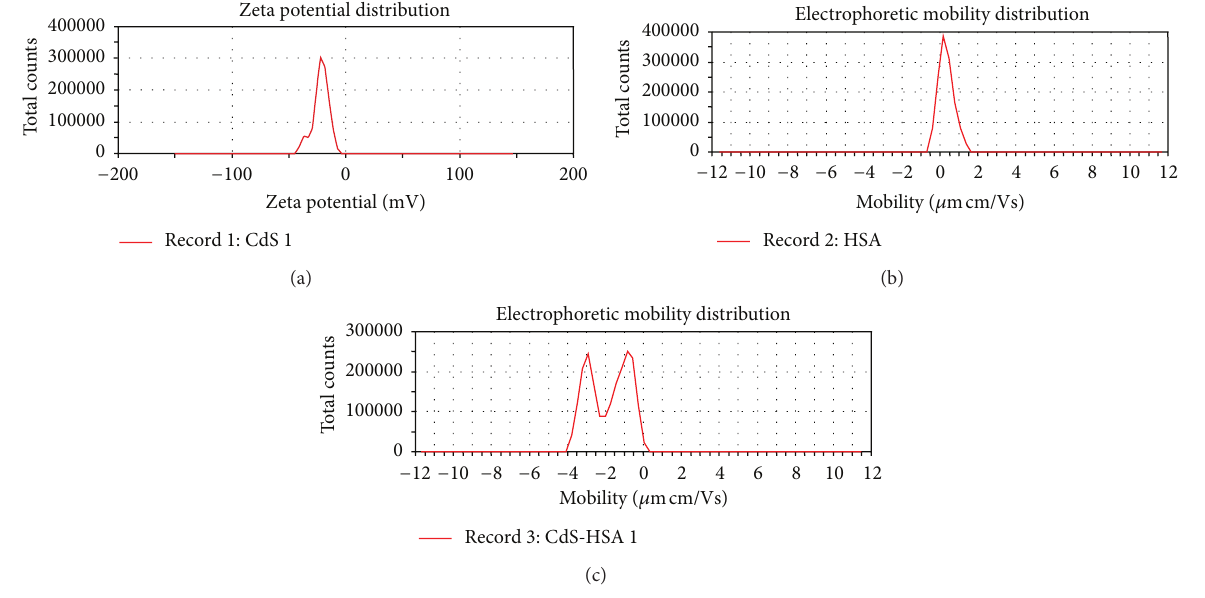
Figure 7: The zeta potential images of ( CdS ) 𝑛 and the binding products of HAS. (a) The zeta potential image of ( CdS ) 𝑛 . (b) The zeta potential image of HSA. (c) The zeta potential image of the ( CdS ) 𝑛 binding with HAS. Table 4: Results for the determination of HSA in urine and serum